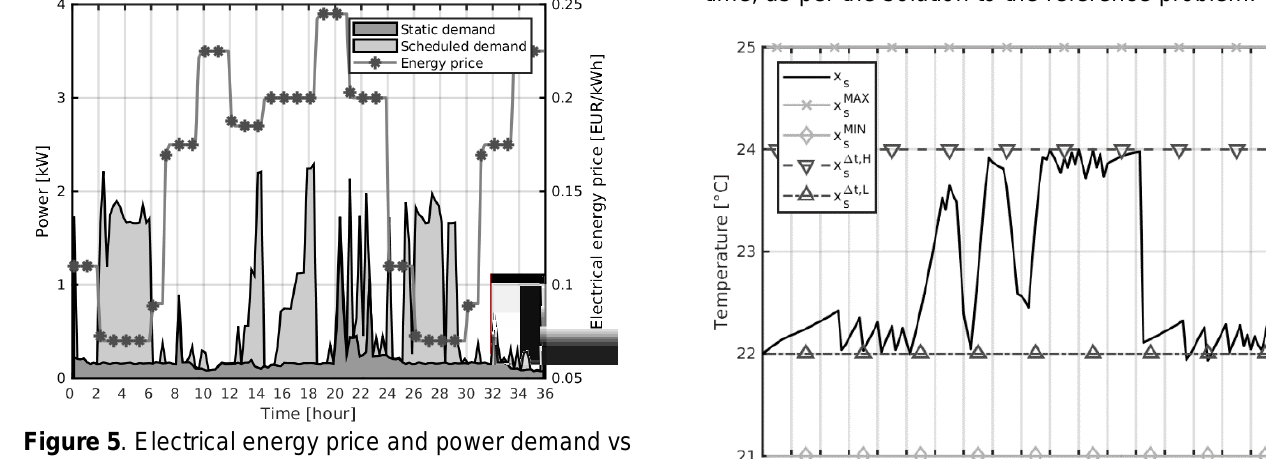
Figure 6. Refrigerator temperature vs. planning period time, as per the solution to the reference problem.